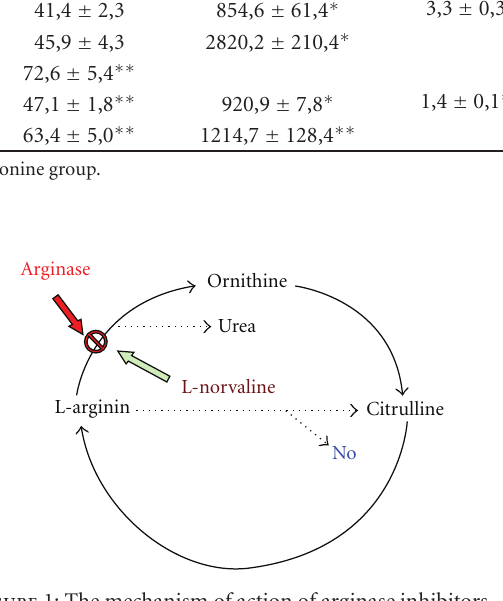
Figure 1: The mechanism of action of arginase